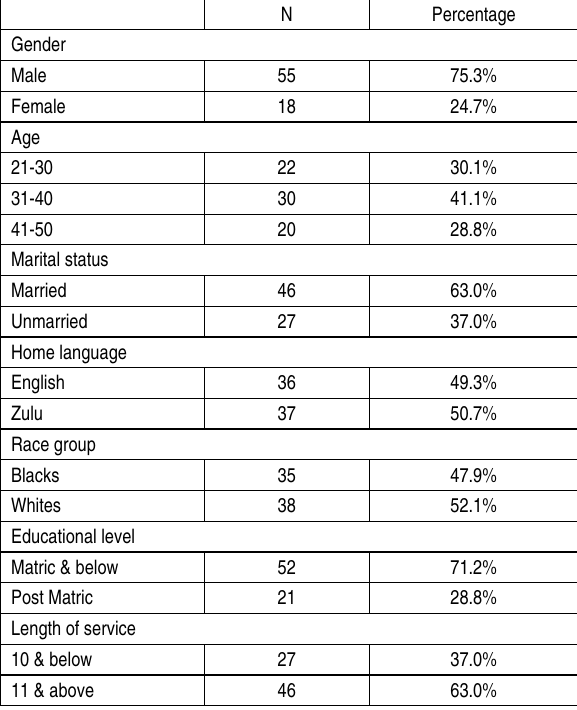
Table 1. Characteristics of the sample